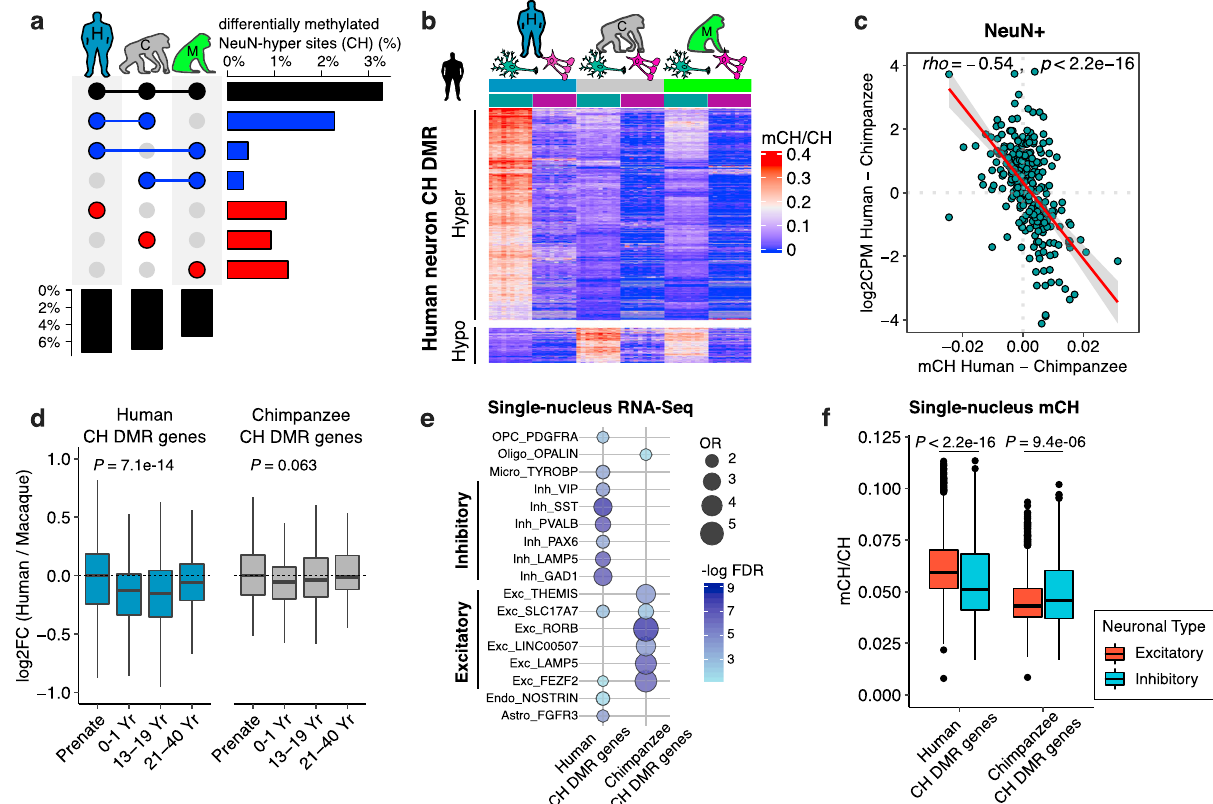
Fig. 3 CH hypermethylation is signi fi cantly higher in human neurons compared to other primates. a Differences in the proportions of sites with neuronal CH methylation between species. b Mean methylation levels of human-speci fi c CH DMRs demonstrate pronounced hypermethylation of human neurons. c CH methylation between humans and chimpanzees strongly predicts gene expression difference. The shaded band represents the 95% con fi dence interval for the fi tted regression line. d Gene expression fold-change between human and macaque in CH DMR genes across developmental time points (Human CH DMR genes, n = 450 and Chimpanzee CH DMR genes, n = 144). Macaque samples were age-matched to human developmental time points in a previous study 14 . Statistical signi fi cance was computed using Kruskal – Wallis test (two-sided). e Enrichment of human and chimpanzee CH DMR genes in speci fi c cell-types. Human CH DMR genes are enriched in inhibitory neurons, whereas chimpanzee CH DMR genes are enriched in excitatory neurons. In each gene set, genes expressed in at least 50% of the cells that are statistically signi fi cant (FDR < 0.05 and log 2 FC > 0.3) are included. Cell-type data are from human medial temporal gyrus (MTG) 36 . f CH methylation of neuronal subtypes for CH DMR genes using methylation of single nuclei from the human frontal cortex 12 . Human CH DMR genes are hypomethylated in inhibitory neurons, whereas chimpanzee CH DMR genes are hypomethylated in excitatory neurons (excitatory neurons, n = 1879 and inhibitory neurons, n = 861). Statistical signi fi cance was computed using two-sided Mann – Whitney U -test. Box represents a range from the fi rst quartile to the third quartile. The line in the box indicates the median value. The minima and maxima are within 1.5 times the distance between the fi rst and third quartiles from box. Source data are provided as a Source Data fi le. Cell-type images were color modi fi ed from the original image, which was created by Akiyao and available at the Wikimedia Commons under the Creative Commons license (https://creativecommons.